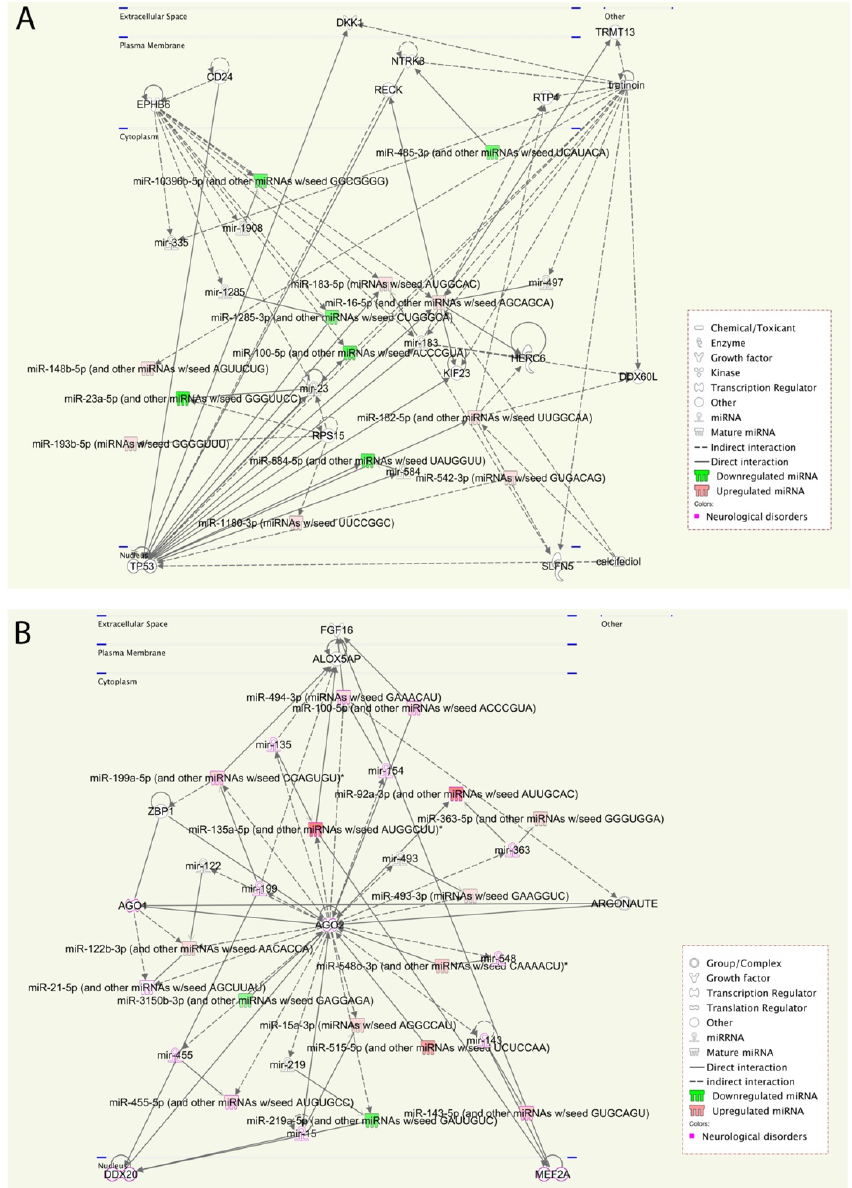
Figure 5. Most highly rated network through IPA analysis in ( A ) ASD cases vs. Controls and ( B ) ASD cases with severe symptoms vs. mild. ( A ) The network representation of the most highly rated networks [Neurological Disease, Organismal Injury and Abnormalities, Psychological Disorders] and ( B ) [Gene Expression, Organismal Injury and Abnormalities, Reproductive System Disease]. The genes that are shaded were determined to be significant from the statistical analysis. The genes shaded red are upregulated and those that are green are downregulated. The molecules highlighted in pink are those identified in neurological disorders. The intensity of the shading shows to what degree each gene was up- or down-regulated. A solid line represents a direct interaction between the two gene products and a dotted line represents an indirect